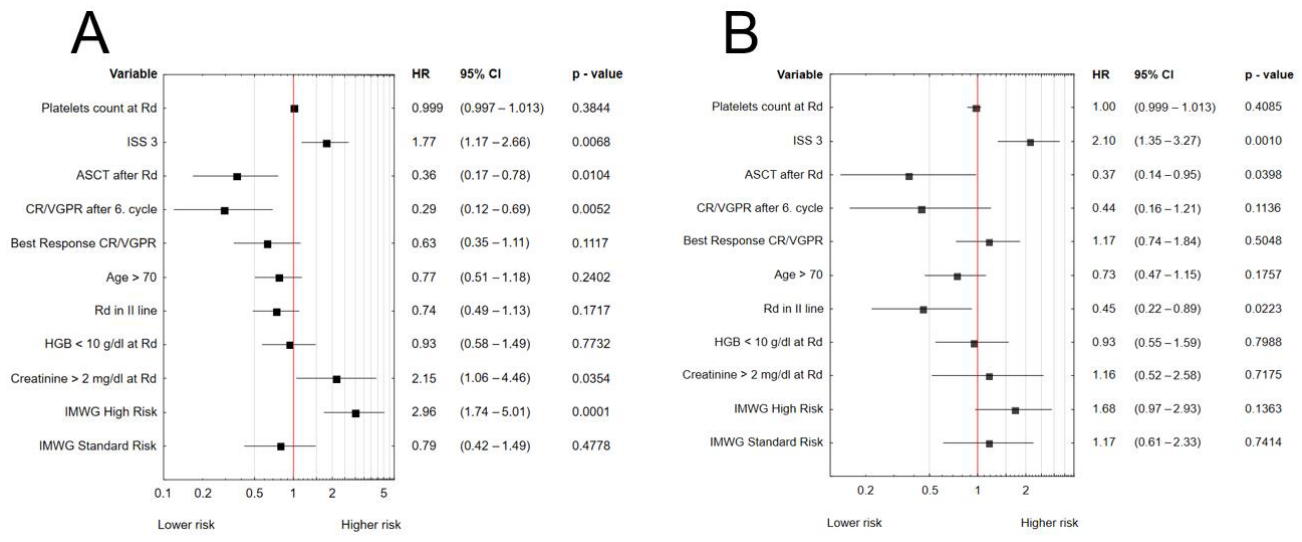
Figure 1. Multivariate Cox regression analyses for PFS ( A ) and OS ( B ).